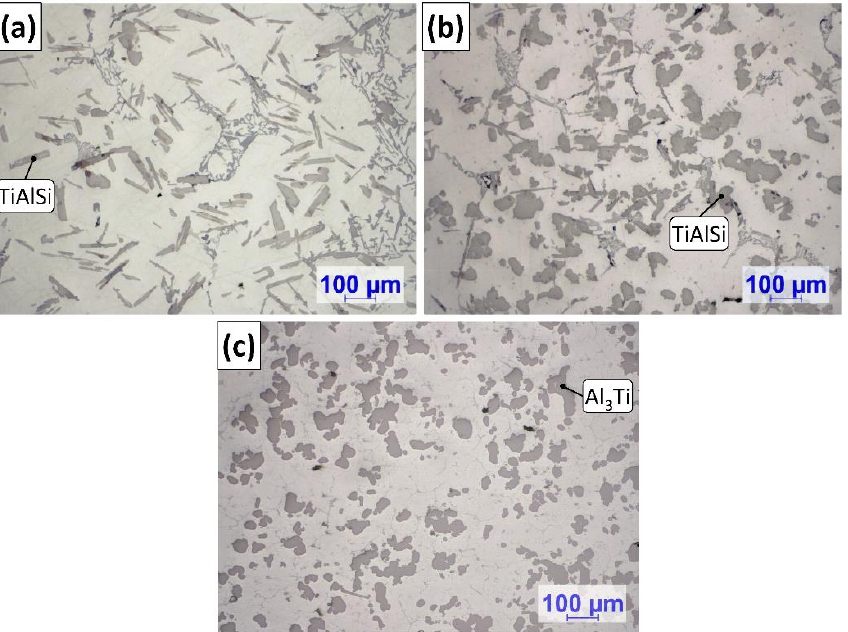
Figure 5. Optical micrographs of the TiAlSi particles formed during the ( a ) A1 and ( b ) A2 experiments, as well as the ( c ) microstructure of the Al-10%Ti master alloy.